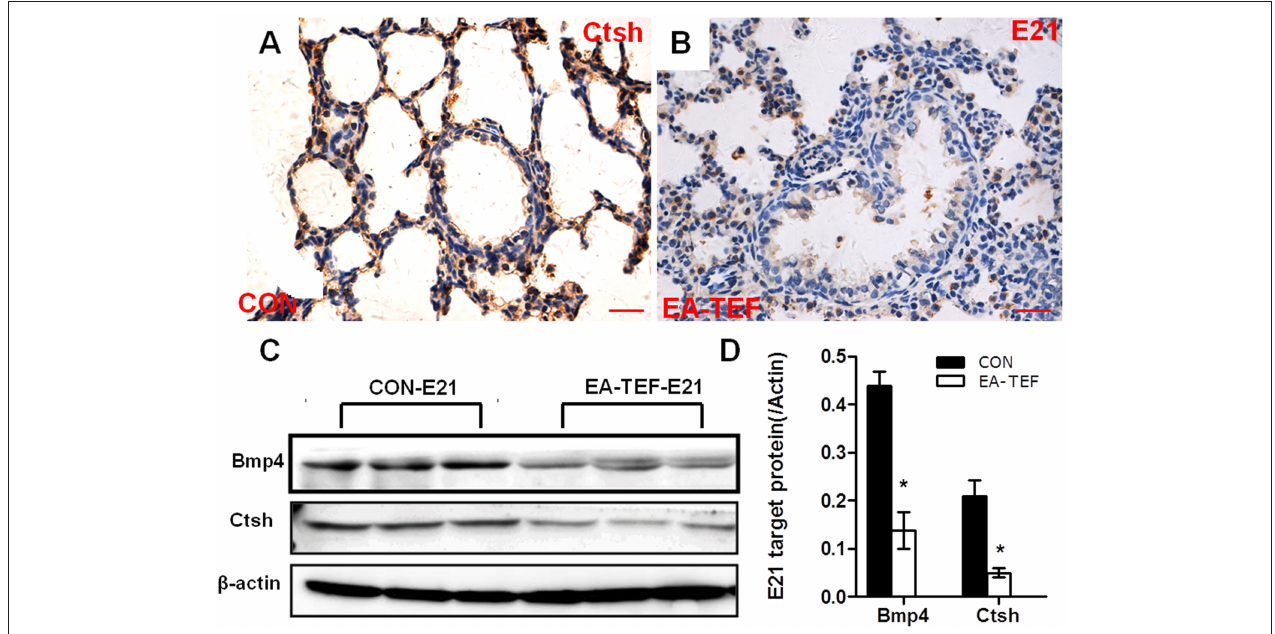
FIGURE 2 | Histological localization and quantification of Ctsh and Bmp4 protein in fetal lungs. (A,B) Representative photomicrographs of IHC- staining for Ctsh in the lung sections from Con (A) and EA-TEF (B) of E21. (Original magnification × 400, scale bar = 100 µ m). Ctsh was mainly expressed in the bronchial epithelial cells. Ctsh protein seemed decreased in EA lungs compared with age-matched control. (C,D) Representative immunoblotting and densitometric analysis of Bmp4 and Ctsh protein expression in fetal lungs at E21 normalized against β -actin expression. * P < 0.05, vs. control at the same time point.